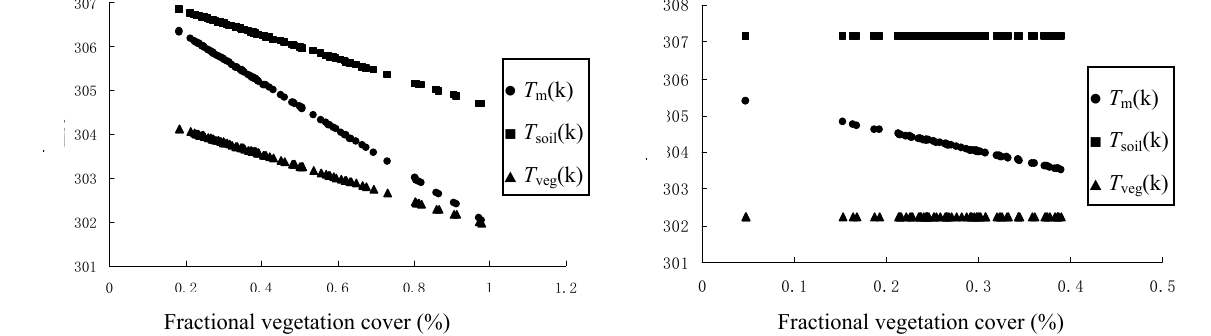
Figure 4. Comparisons between T obtained from the improved model at iso-line of equal water